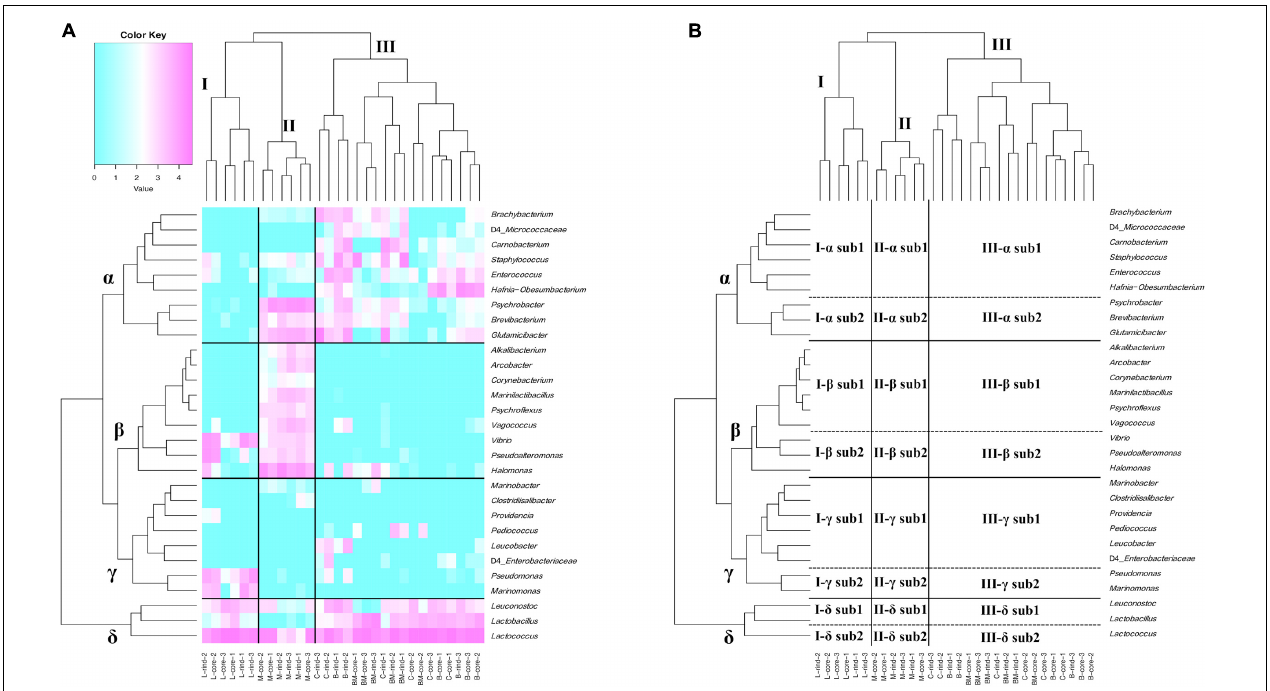
FIGURE 2 | Hierarchical clustered heat map based on the relative abundance of bacteria genus detected on 30 cheese samples. (A) Relative abundance of bacteria genus is shown on heat map with dendrogram. Only bacteria with relative abundance > 0.5% in at least one sample are shown. Purple indicates high occupancy and light blue indicates low or non-existent occupancy. (B) Hierarchically clustered map. Cheese sample clusters are represented by I, II, and III. Bacteria clusters are represented by α , β , γ , and δ . Each bacteria cluster is further divided into sub1 and sub2. B, Brie de Meaux; BM, Brie de Melun; C, Coulommiers; L, Langres; M,